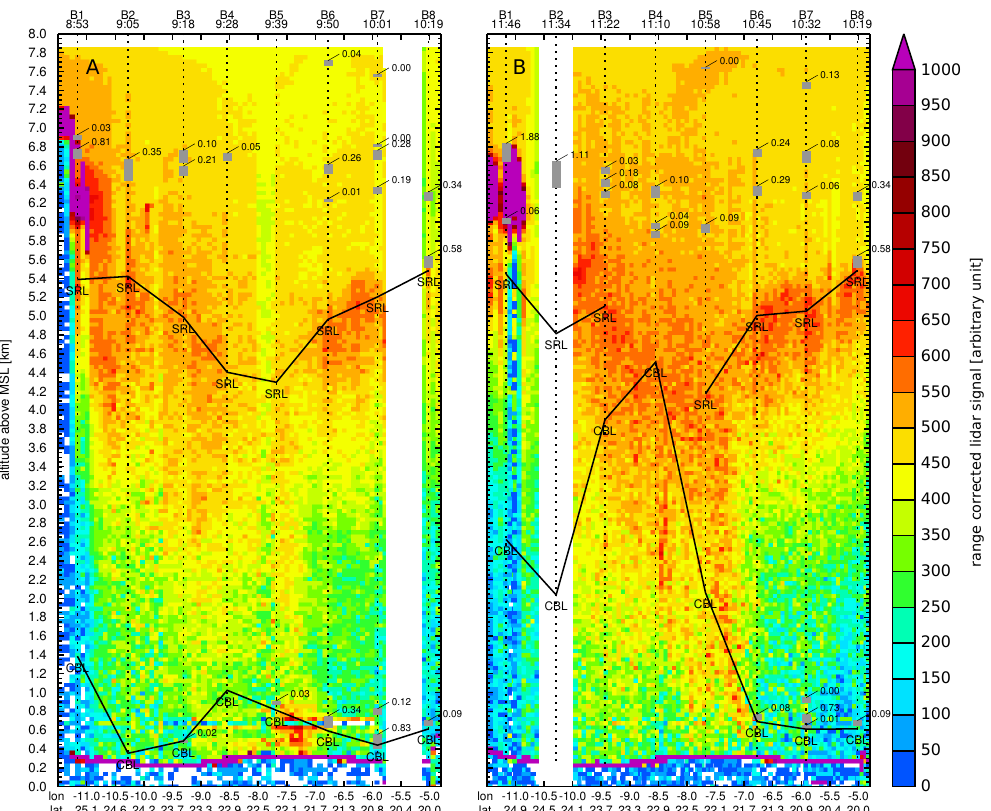
Figure 17. Lidar and dropsonde observations from 22 June 2011 morning flight b607 (yellow line in Fig. 2c) plotted along longitude for the (a) outgoing and (b) return legs. BAe146 lidar measurements (coloured boxes) are shown as the range-corrected lidar backscatter signal 355nm. White regions identify periods of lidar data dropouts. Dotted vertical lines indicate dropsonde locations. Black solid lines mark the top of the CBL (convective boundary layer) and SRL (Saharan residual layer). Grey boxes along dropsonde tracks show depth of temperature inversions (change in ◦ Ckm − 1 shown next to the box). Purple line indicates ground level. Dropsonde location ID and release time are indicated above each dropsonde